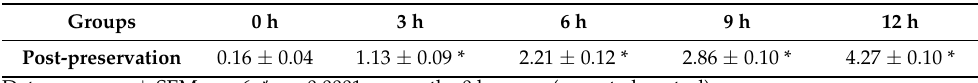
Table 1. Mucosal injury scores after cold preservation.